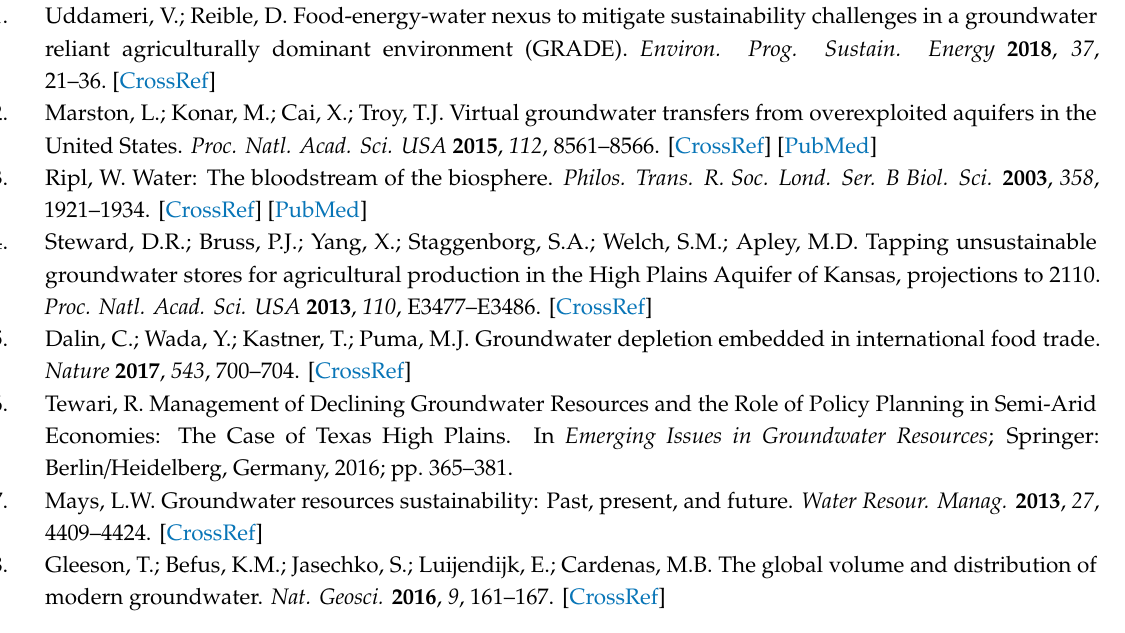
Figure S1: Cross-Sectional Profiles of Dockum HSG, Table S1: Water Quality Standards for Municipal and Hydraulic Fracturing Use (Data from [61] and [50]; Secondary standards for Municipal Use (SMCLs) are presented in parenthesis; All units are mg / L unless noted otherwise), Table S2: Water Quality Criteria for Agricultural FFP Assessment